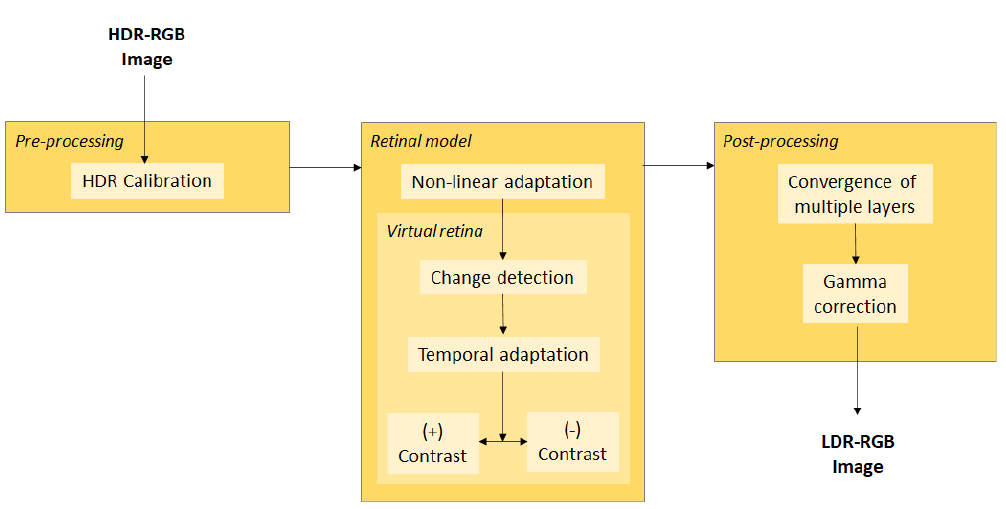
Figure 3. Schematic description of the pre-processing, retina model using Virtual Retina, and post-processing general operator. HDR: high dynamic range, RGB: Red, Green, Blue color model, OPL: outer plexiform layer, CGC: contrast gain control, LDR: low dynamic range. Modified after Benzi et al. [92].